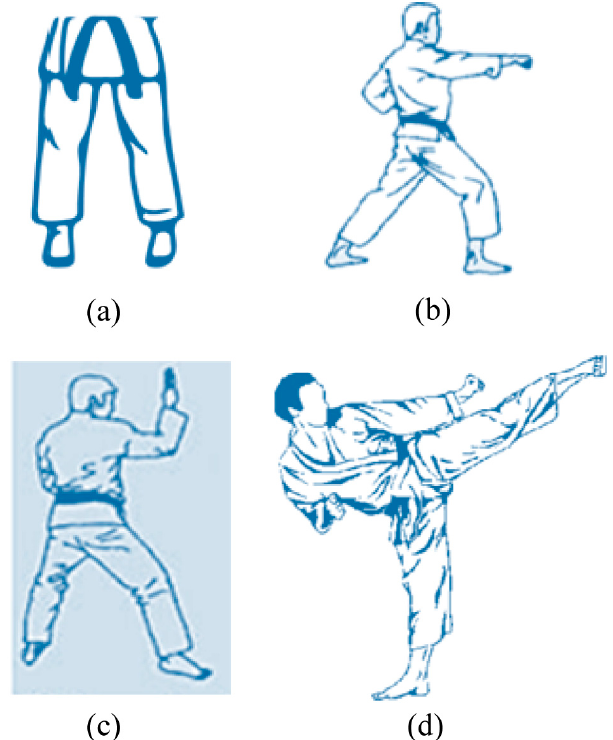
Figure 4. Examples of karate shots and stances evaluated in the study: ( a ) Heiko Dachi (parallel stance) stance; ( b ) Juntzuki (lunge punch) on Zenkutsu Dachi (forward leaning stance) stance; ( c ) Shuto Uke (knife hand block) on Shomen Neko Aishi Dachi (front facing cat leg stance) stance; ( d ) Sokuto Geri (lateral kick).